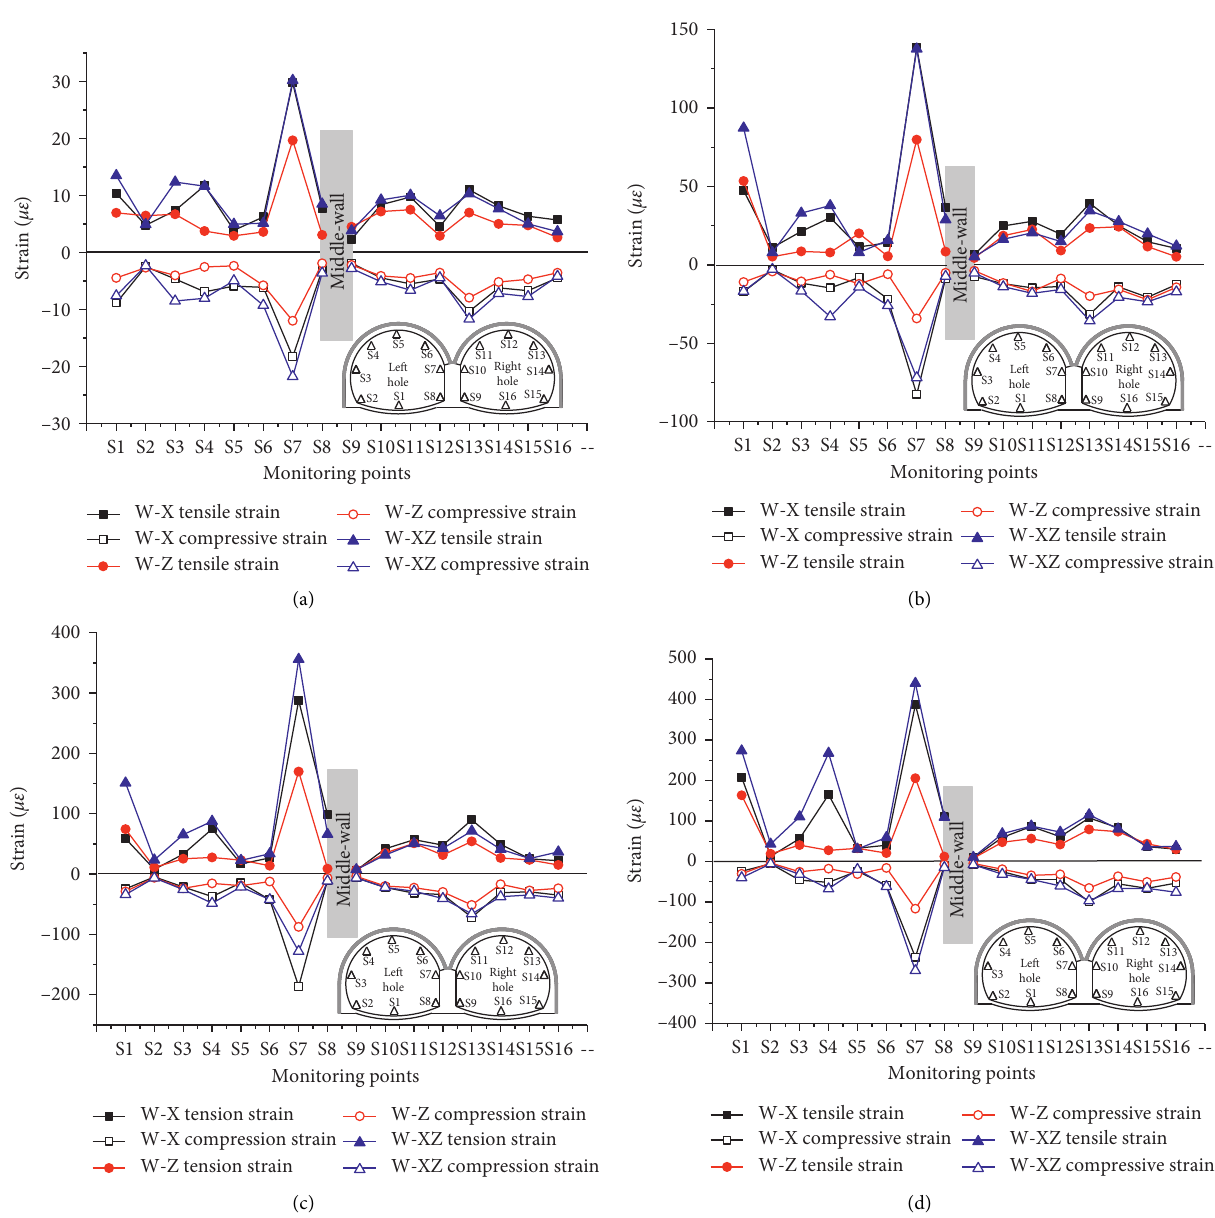
Figure 21: Variation trends of the peak strain: (a) 0.1g, (b) 0.2g, (c) 0.4g, and (d)